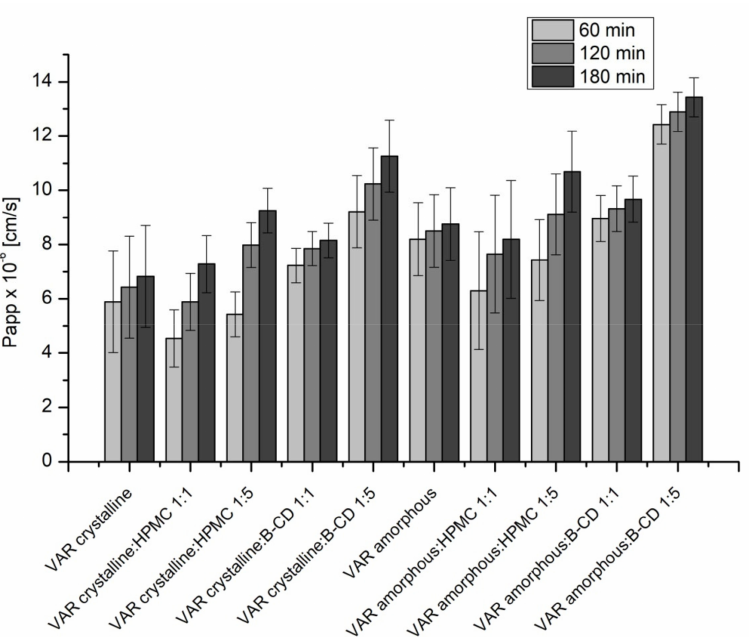
Figure 7. Apparent permeability of amorphous and crystalline of VAR in free form and systems with HPMC and β -CD in 1:1 and 1:5